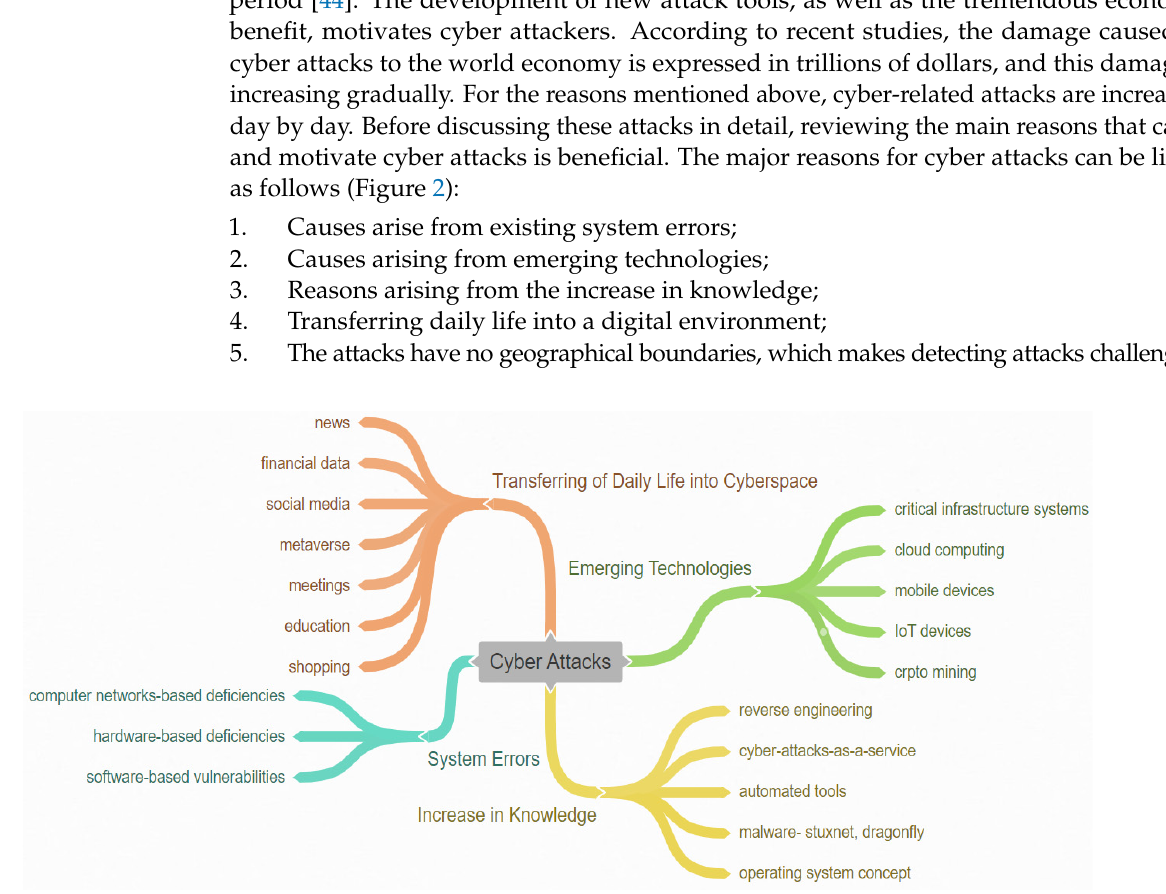
Figure 2. Main reasons for cyber attacks.